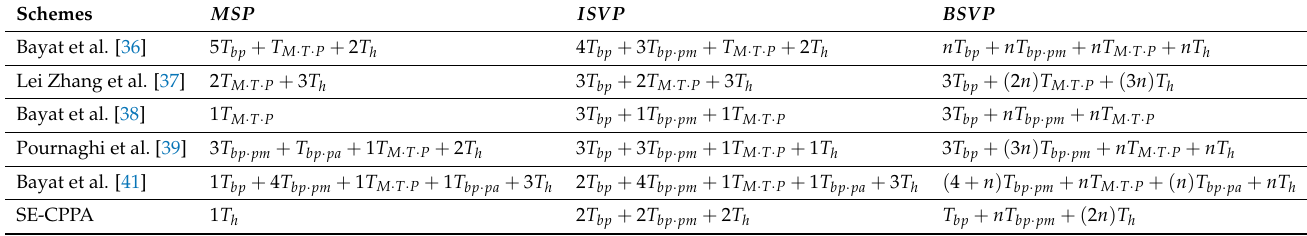
Table 5. Cost of computation